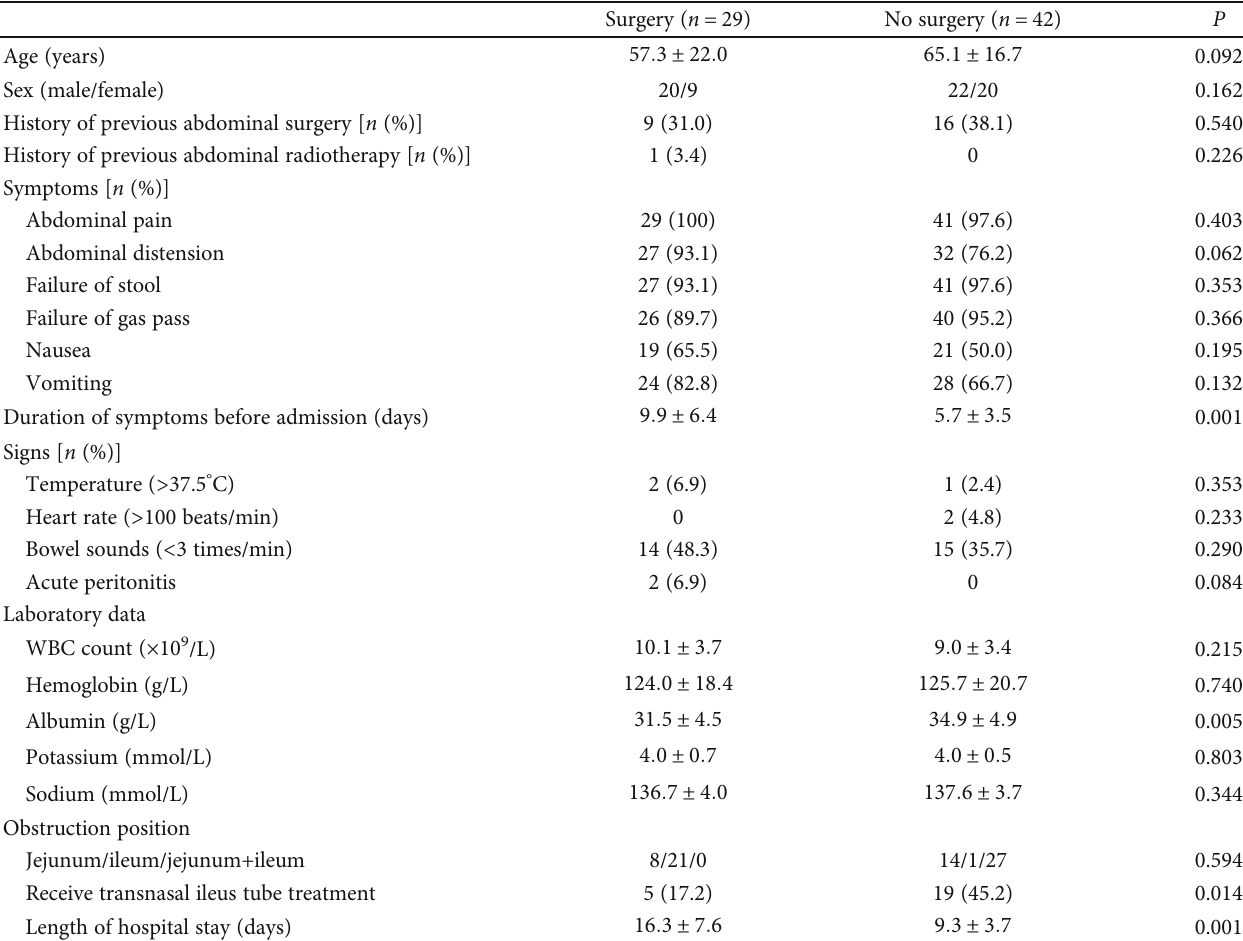
Table 4: Univariate analysis of factors of patients ’ transition to